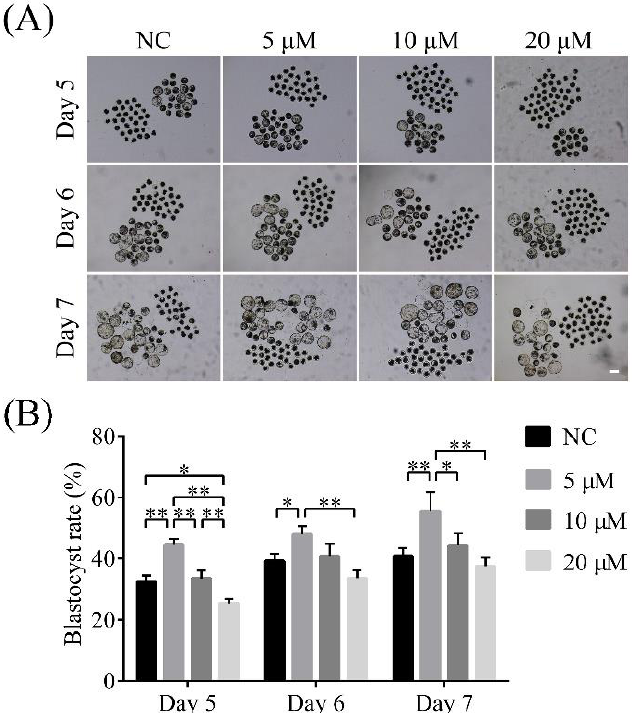
Figure 1. Effects of 6-gingerol (6-G) on blastocyst formation rate of porcine early embryos. ( A ) Representative images of embryos on day 5, day 6, and day 7 treated with 0 µ M, 5 µ M, 10 µ M, or 20 µ M 6-G, respectively. Scale bar = 200 µ m. ( B ) Blastocyst formation rates on day 5, day 6, and day 7 treated with 0 µ M, 5 µ M, 10 µ M, or 20 µ M 6-G, respectively. R = 3. * p < 0.05; ** p < 0.01.